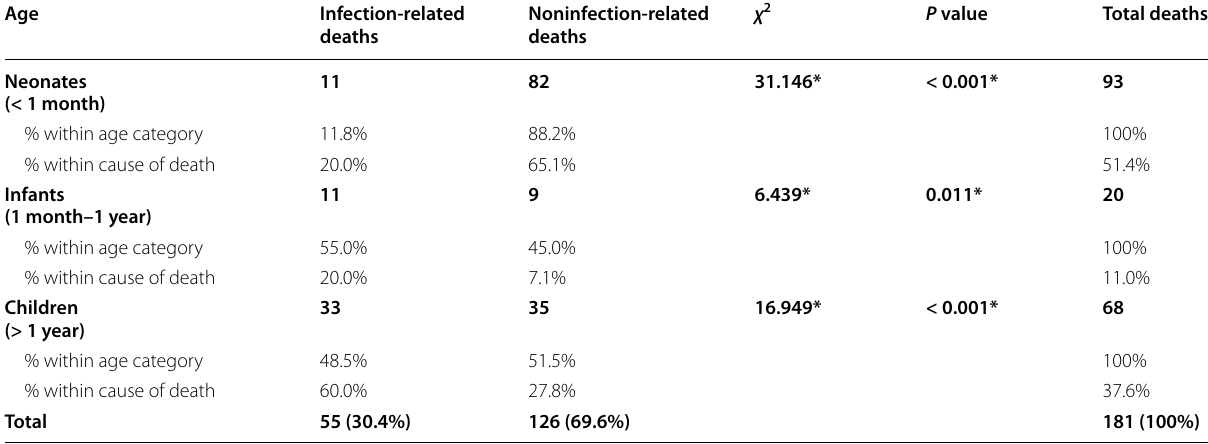
Table 2 Infection and noninfection‑related deaths in different pediatric age categories ( n